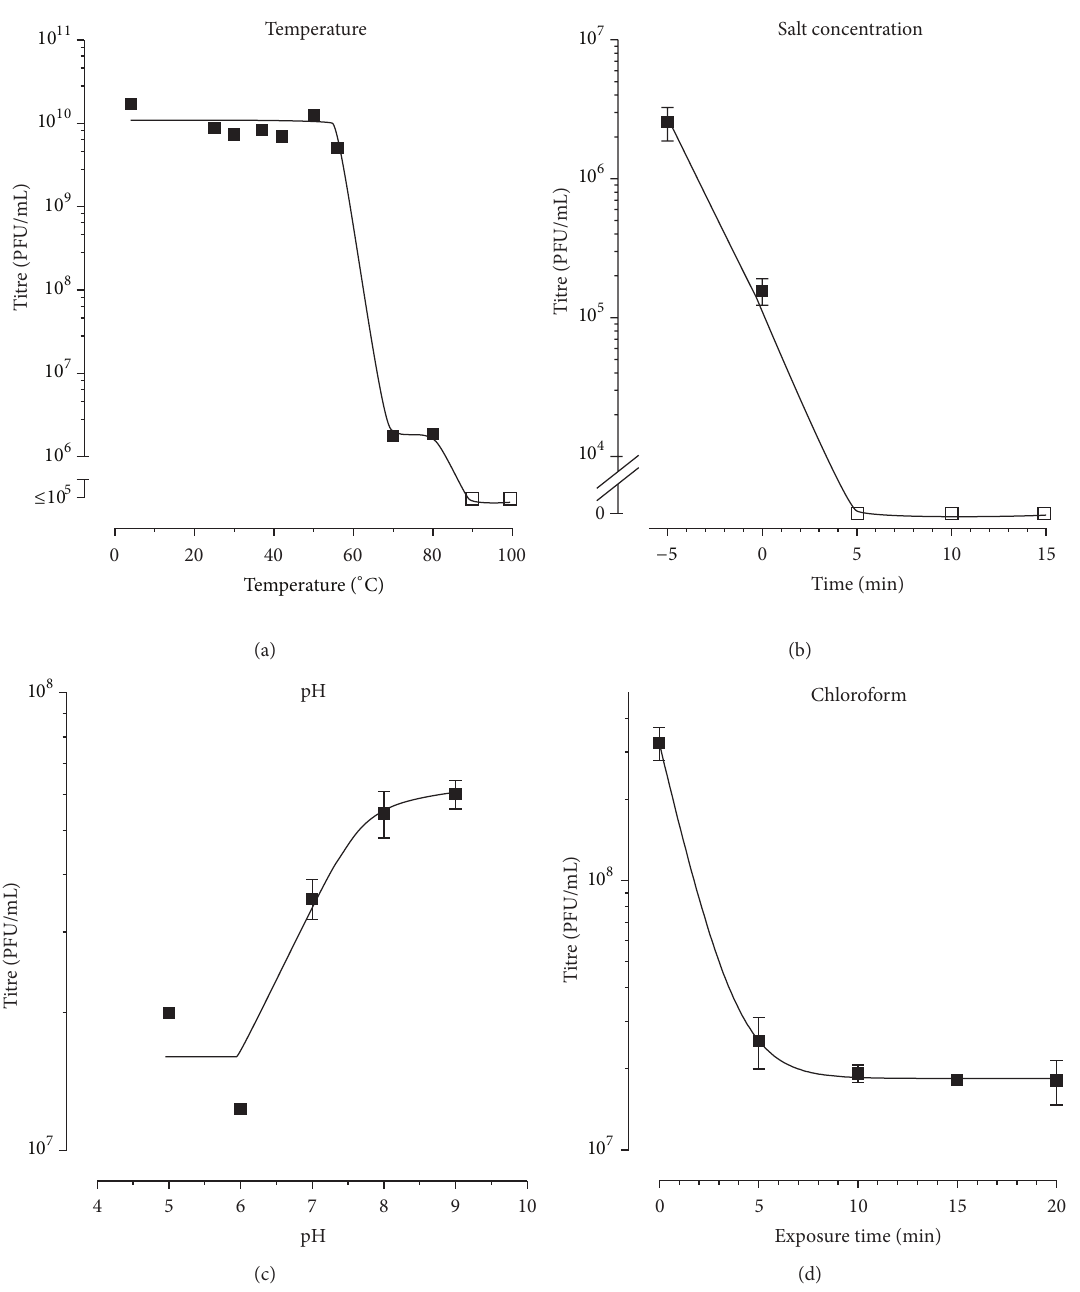
Figure 3: Stability of PH1 virus to various treatments and conditions. Virus preparations (infected-cell supernatants in 18% (w/v) MGM) were exposed to various conditions, after which the virus titre was determined (in duplicate) on Har. hispanica cells. (a) The effect of temperature. Virus was incubated for 1hr with constant agitation at temperatures between 4 and 100 ∘ C. (b) The effect of lowered salt concentration. Virus was diluted 1:1,000 in double-distilled H 2 O and incubated at room temperature, with constant agitation. Samples were removed at regular intervals.(c)TheeffectofpH.Viruswasdiluted1 :100inTris-HClbuffersatthedifferentpHsandincubatedwithconstantagitationfor30min. (d)Theeffectofchloroform.Chloroformwasmixedwithvirus(1 : 4ratio)andincubatedatroomtemperaturewithconstantagitation.Samples were removed at regular intervals. Open square symbols indicate where virus titres were undetectable. Error bars represent one standard deviation of the average